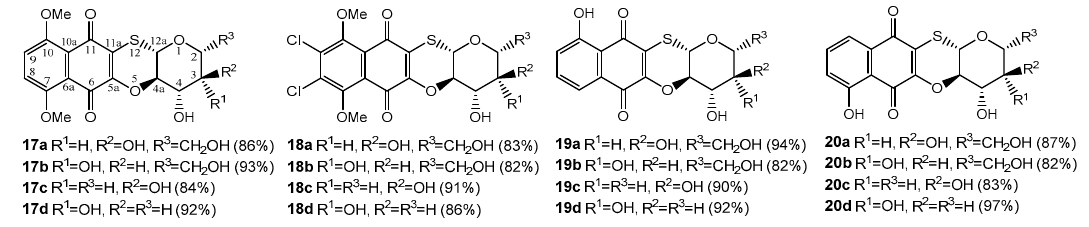
Figure 3. Synthesized 1,4-naphthoquinone-thioglycoside tetracyclic conjugates.